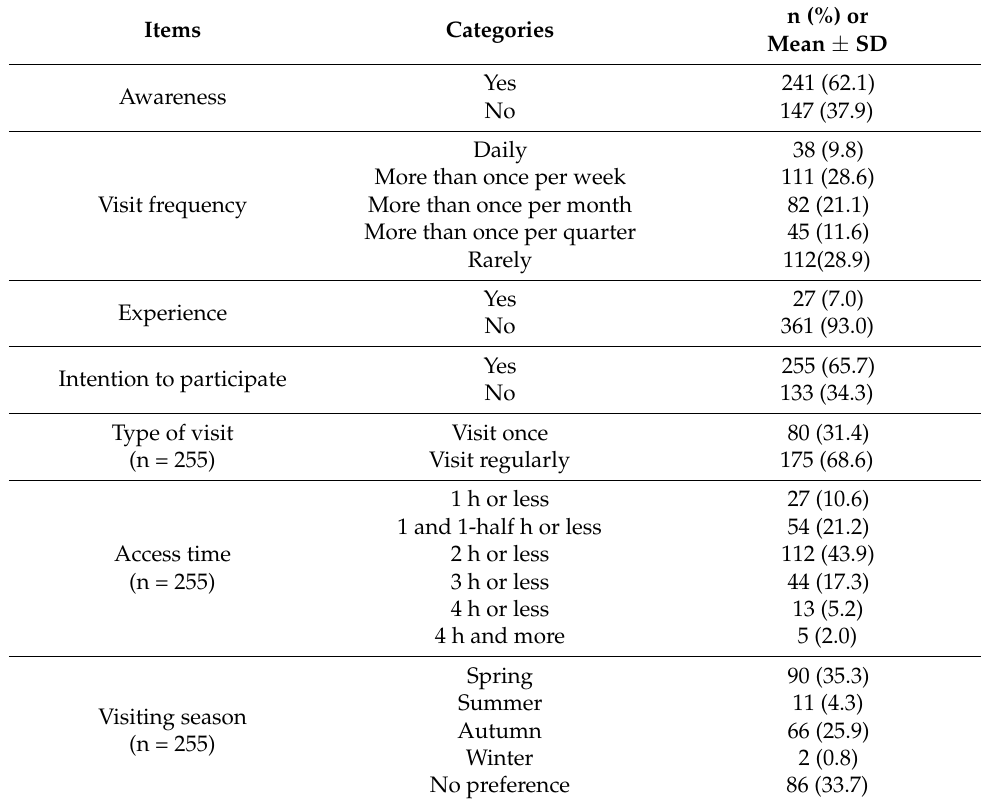
Table 3. Preference in forest healing program (N = 388).